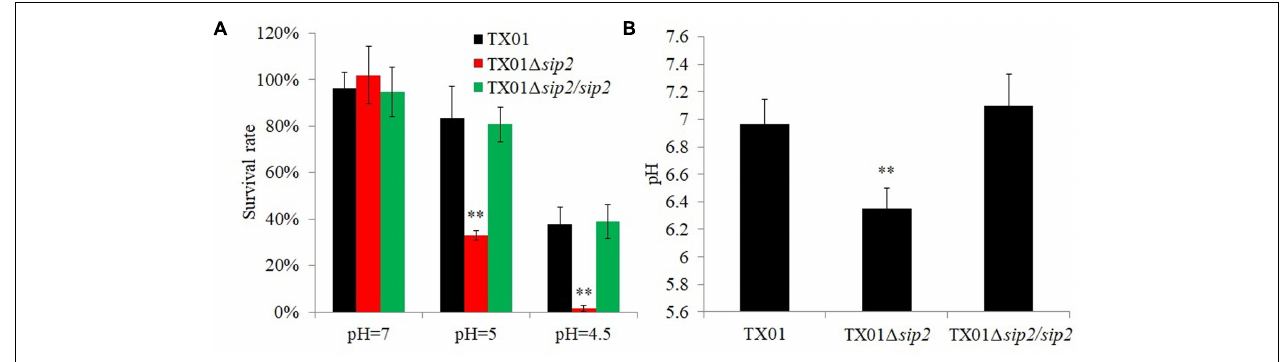
FIGURE 5 | Survival of Edwardsiella tarda against acidic stress. (A) TX01, TX01 (cid:49) sip2 , and TX01 (cid:49) sip2 / sip2 were incubated at different pH for 2 h, and bacterial survival was determined. (B) TX01, TX01 (cid:49) sip2 , and TX01 (cid:49) sip2 / sip2 were incubated at pH 5 for 2 h and lysed, and the pH of the cell lysate was determined. Data are the means of three independent assays and presented as means ± SEM. ∗∗ P < 0.01, ∗ P < 0.05.